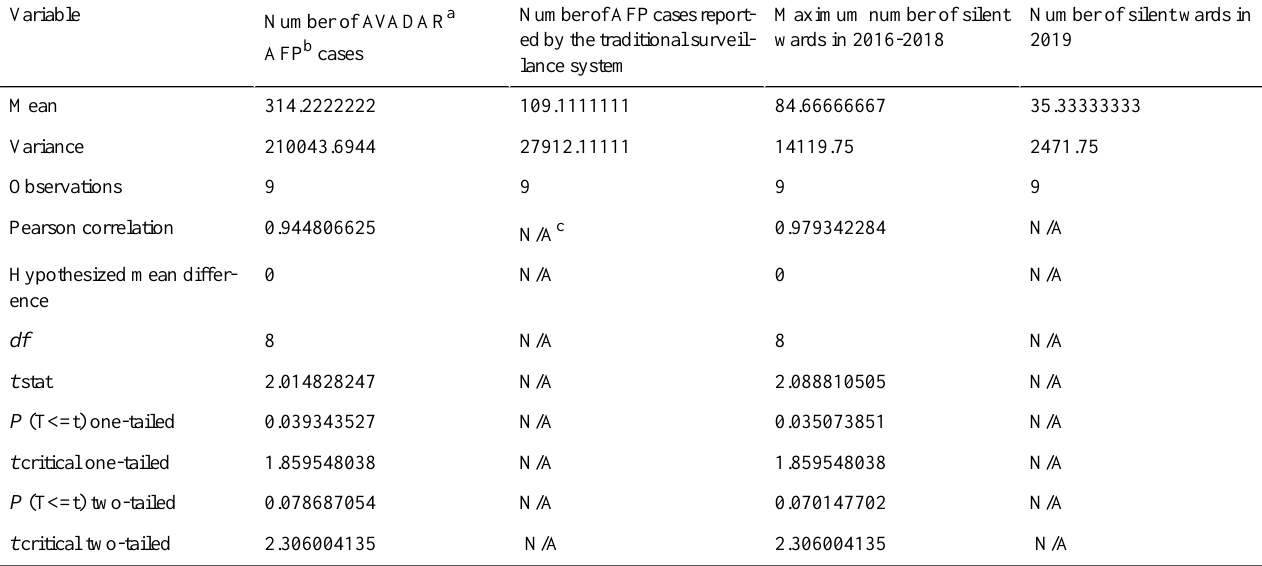
Table 4. Comparison of mean, standard deviation, and P value of the Auto-Visual Acute Flaccid Paralysis Detection and Reporting (AVADAR) system and traditional surveillance system regarding acute flaccid paralysis reporting and silent wards (2017-2018).